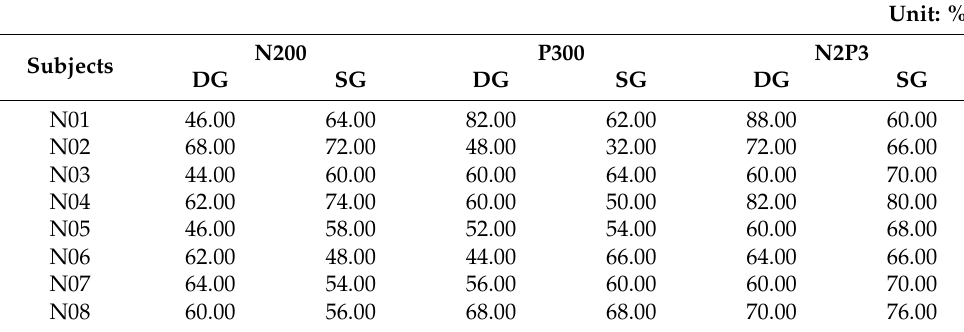
Table 10. The average accuracies using different-gender (DG) and same-gender (SG)